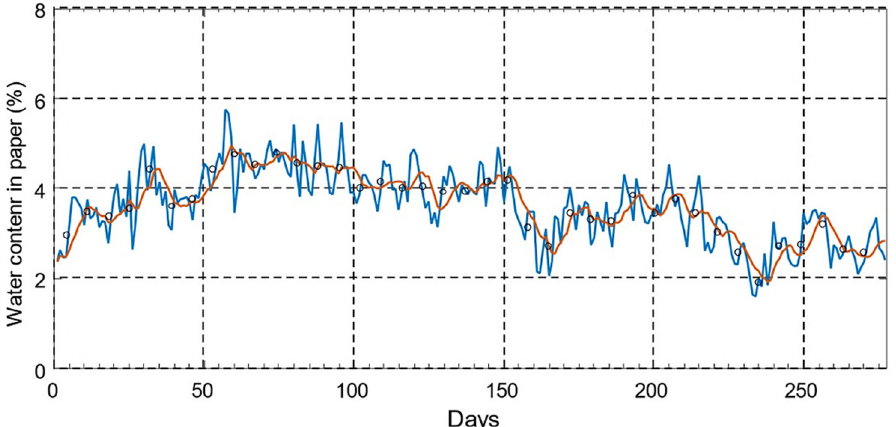
Figure 47. Evolution of water content in the paper. Water content in the paper is in blue, the average of each measurement day weighing the previous seven days is shown in orange, and the average points taken every seven days are shown in black